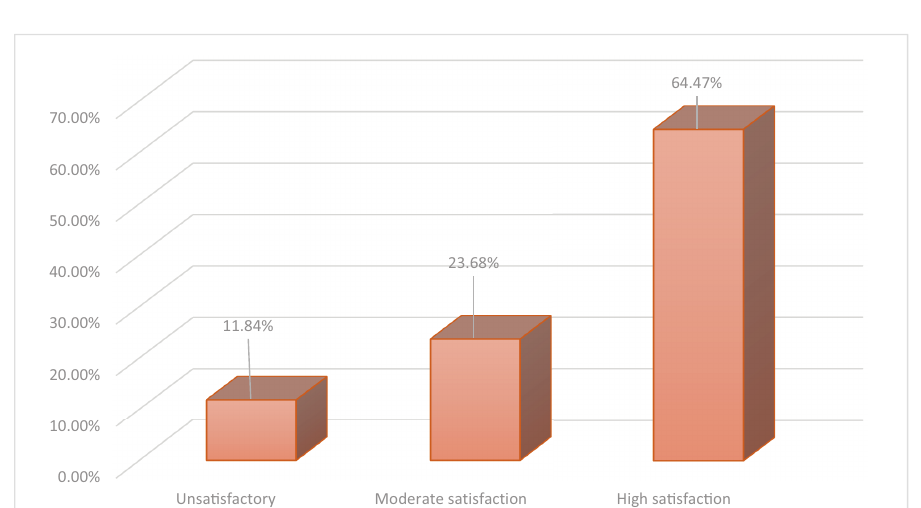
Figure 1 : The level of satisfaction of nursing students toward online learning during